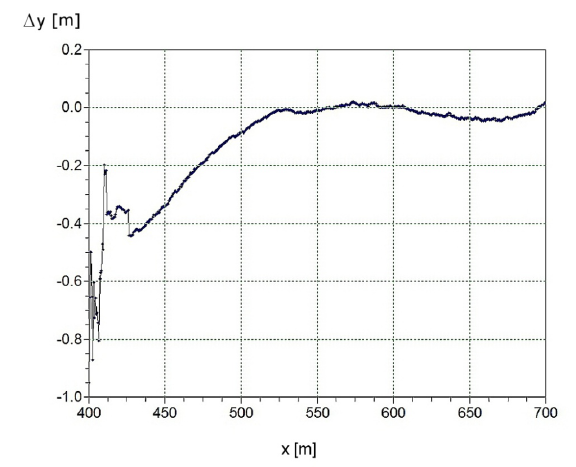
Figure 14: Matching of the circular arc. Radius R = 1000 m; adopted bounds of the measurement points: G L = 400 m and G R = 700